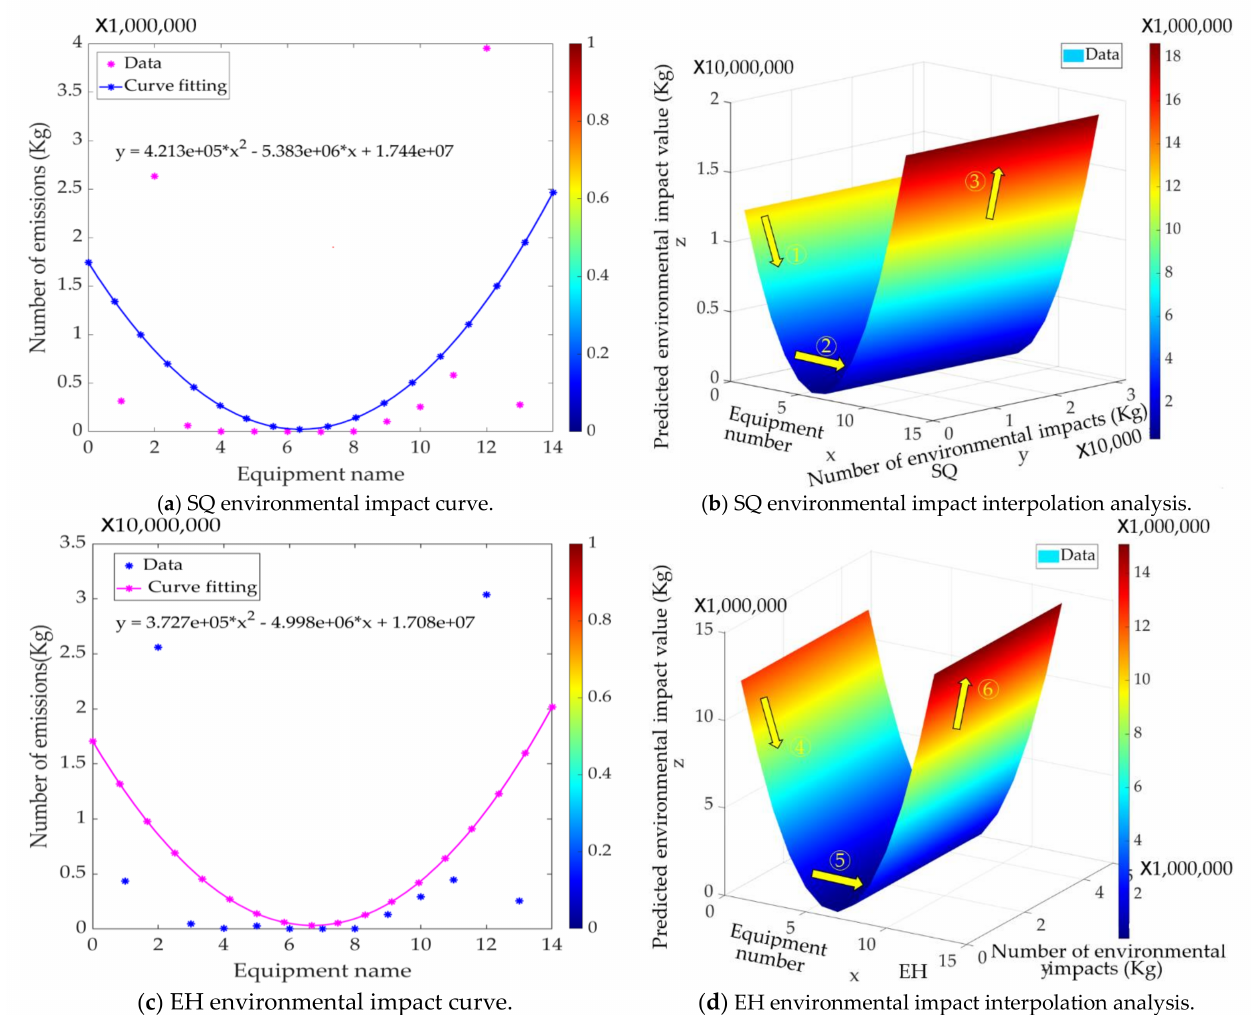
Figure 13. SQ and EH maintenance and operation stage environmental impact fitting and future change trend interpolation